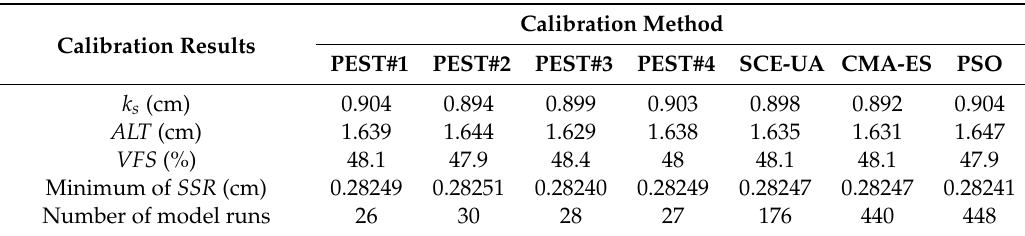
Table 3. Calibration results for the numerical model Run#5 by local and global optimization methods, using Wu’s sediment transport